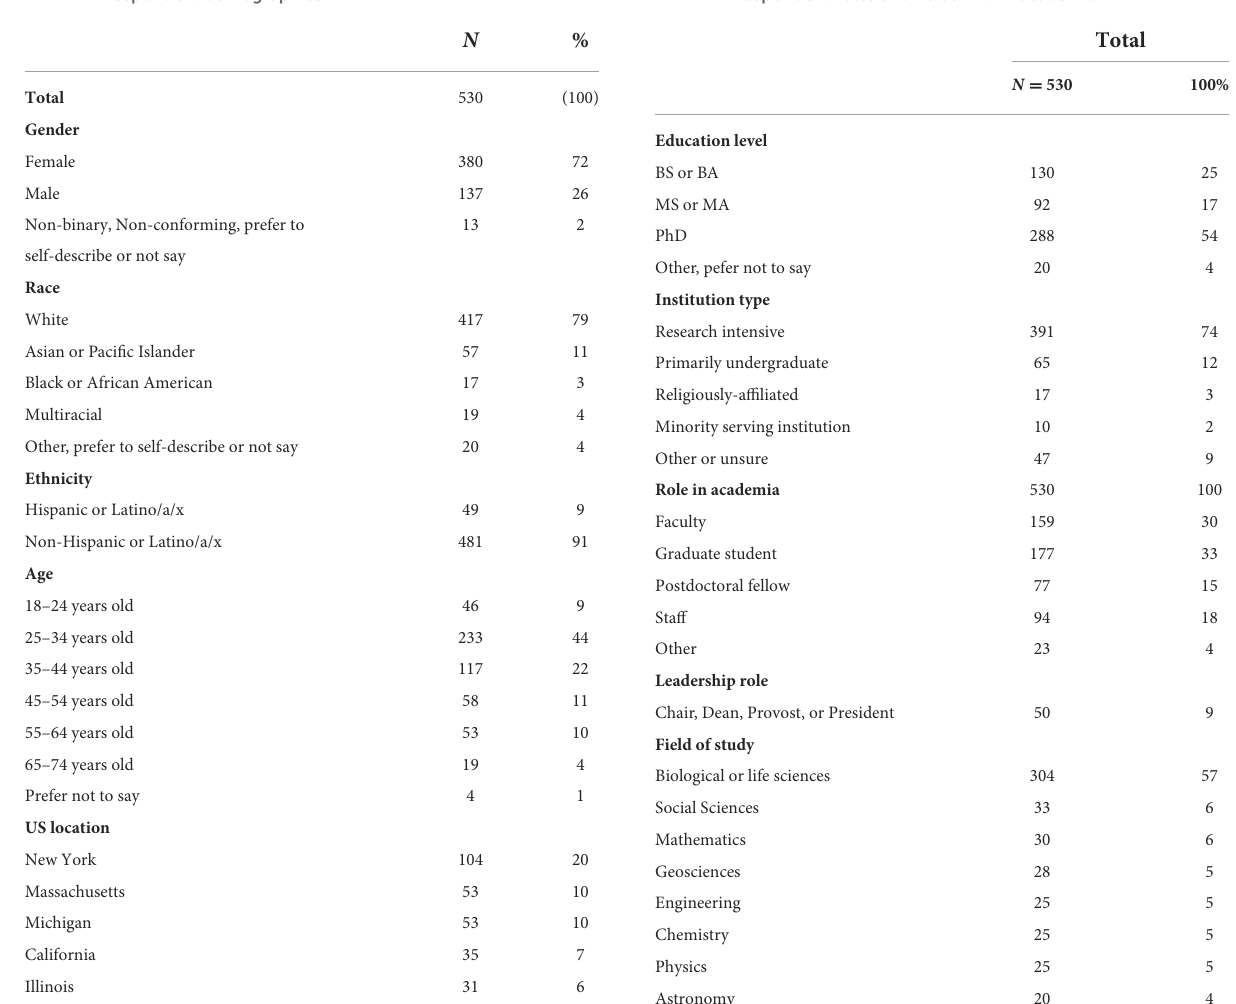
TABLE 1 Respondent demographics. TABLE 2 Respondent roles and fields within